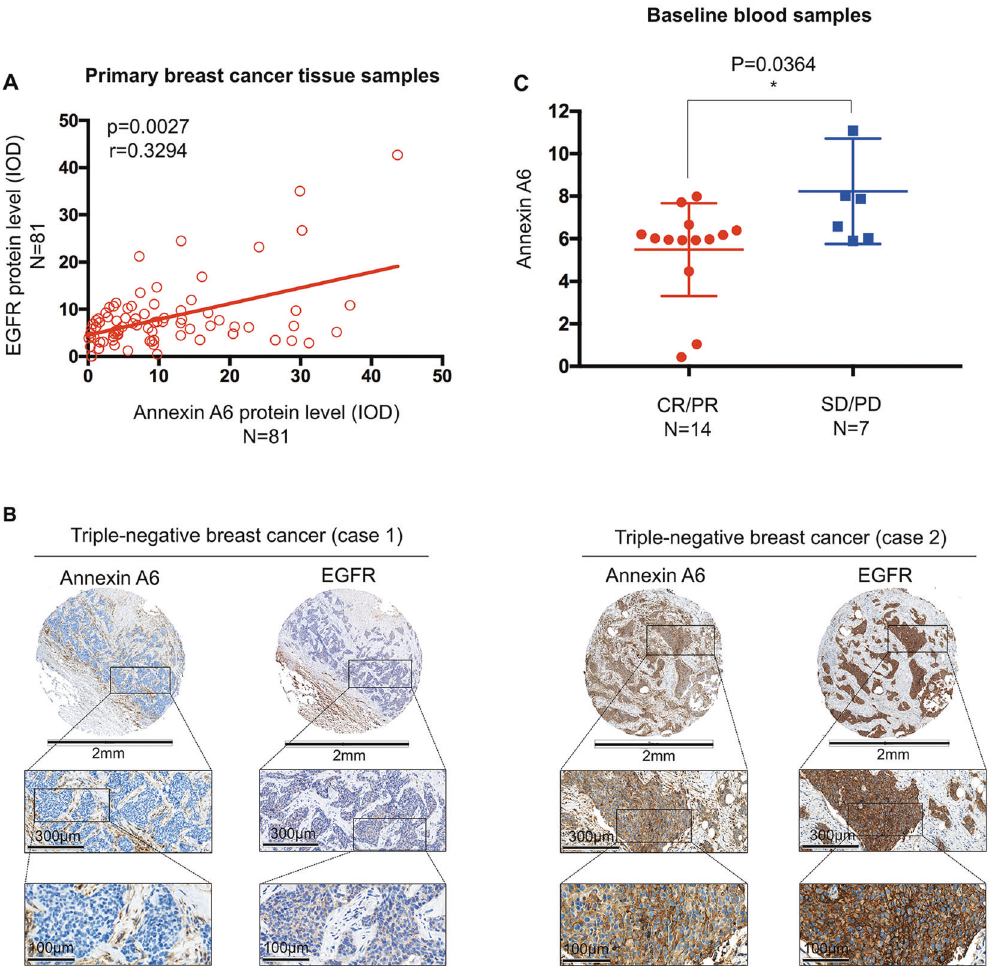
Fig. 7 The positive correlations of ANXA6 and EGFR and exosomal ANXA6 are less enriched in gemcitabine-sensitive patients. A Scatter plot of ANXA6 and EGFR protein levels as assessed via immunohistochemistry using a tissue microarray constructed by samples from 81 patients with triple-negative breast cancer. The baseline characteristics of the 81 patients are shown in Supplementary Table 1. B Representative images of ANXA6 and EGFR immunohistochemistry in primary triple-negative breast cancer tissue. Low ANXA6 protein expression in a tumor with low EGFR protein expression (case 1) and high ANXA6 protein expression in a tumor with high EGFR protein expression (case 2). C ELISA revealed that the baseline levels of exosomal ANXA6 isolated from the serum of patients with triple-negative breast cancer were lower in sensitive patients with the best response of complete or partial responses ( n = 14) than in those with stable or progressive disease ( n = 7). The tumor response was assessed at every two or three cycles. The baseline characteristics of 21 patients are shown in Supplementary Table